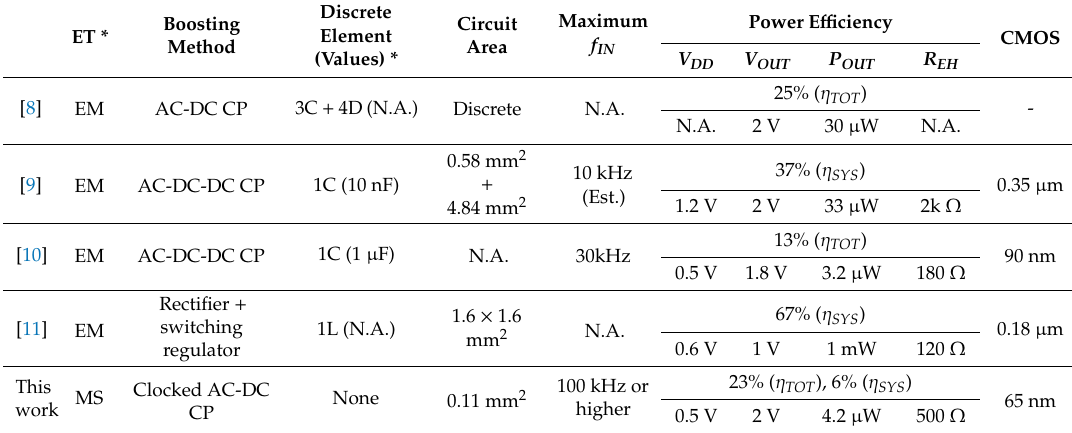
Table 2. Comparison on the